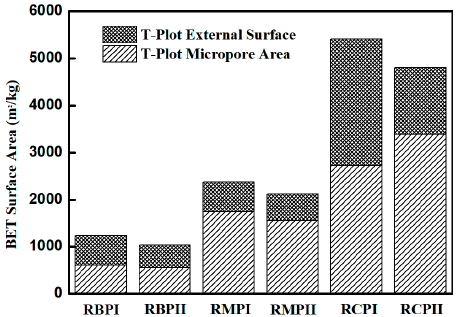
Figure 10. The WRR and fineness of RP.